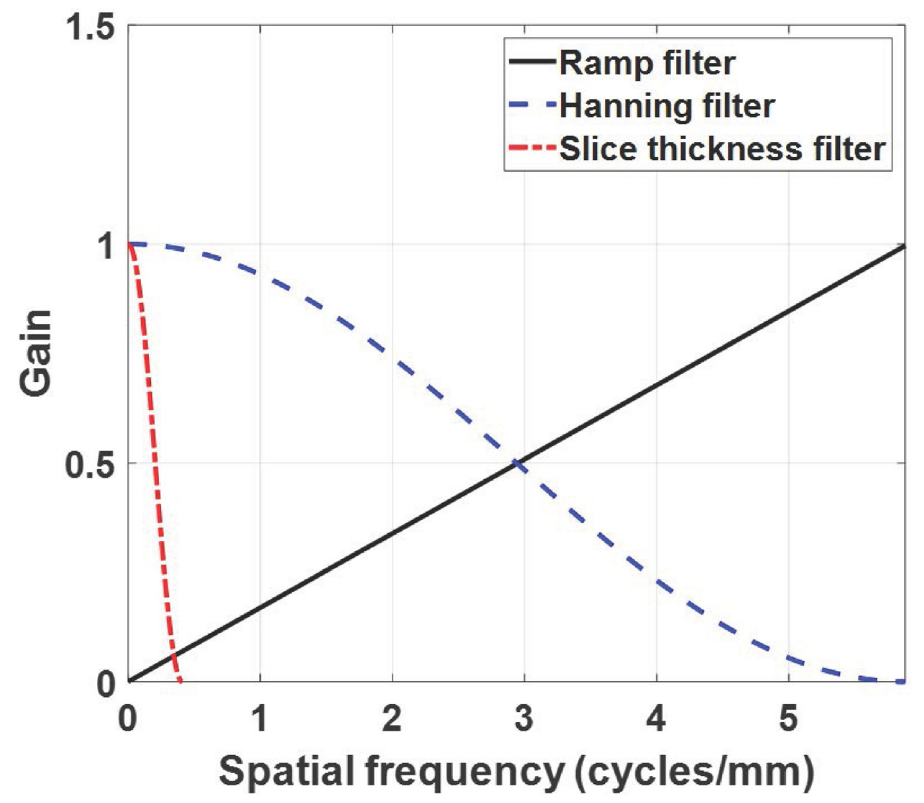
Fig 2. Profiles of the reconstruction filters.